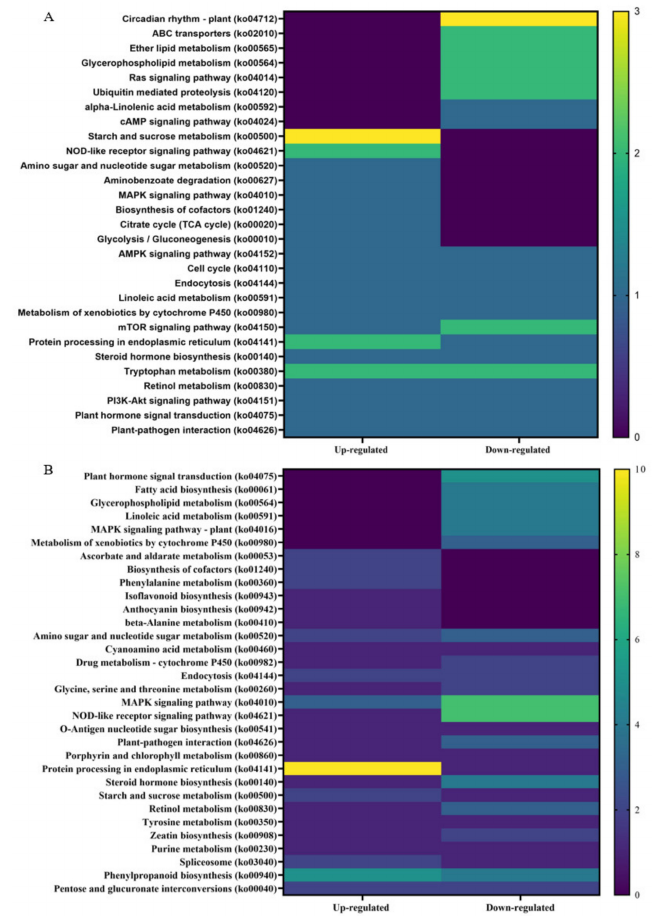
Figure 7. Distribution of Kyoto Encyclopedia of Genes and Genomes (KEGG) pathway classification of upregulated differentially expressed genes (DEGs) between non-infected and citrus dwarfing viroid (CDVd)-infected ( A ) stem and ( B ) root tissues. The heat map shows the KEGG function and the number of associated